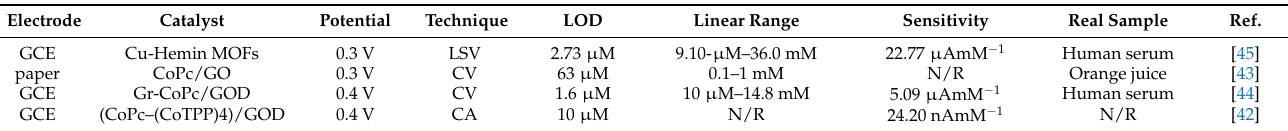
Table 4. Examples of MP and MPc complexes used in the fabrication of enzyme-based electrodes for electrochemical sensing of glucose.